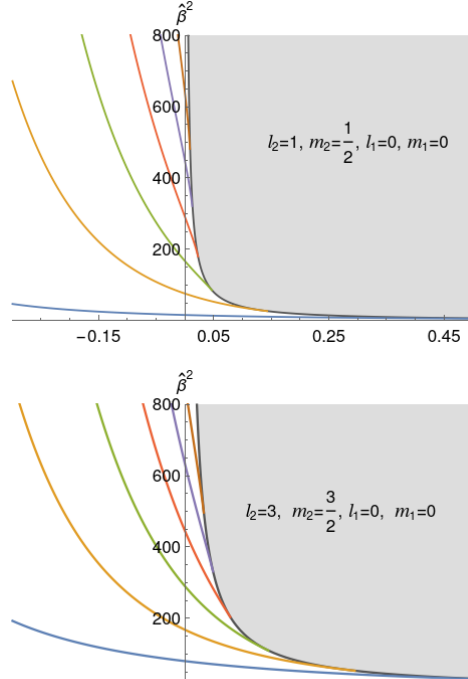
Figure 2 . Spectrum of the first six non-BPS families of eigenvalues parameters given by (5.66), ‘ defined as in figure